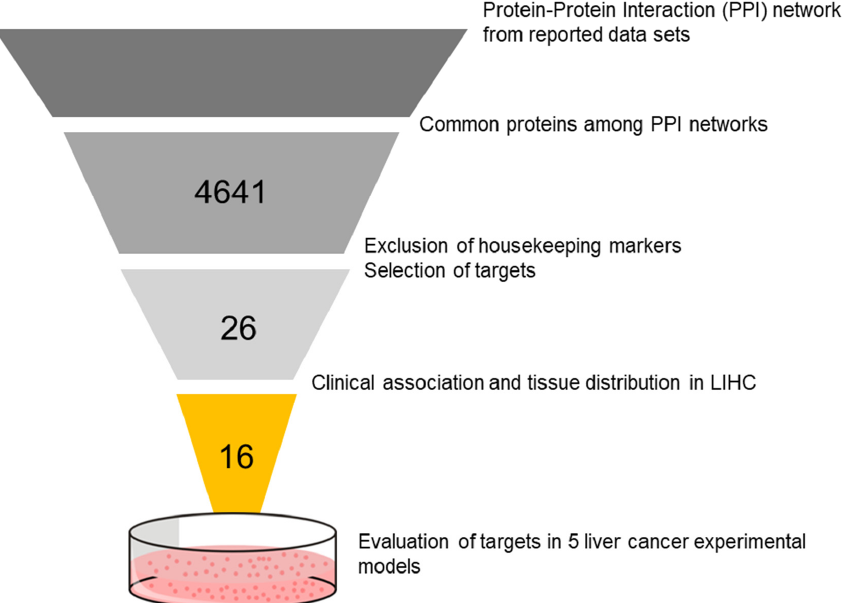
Figure 1. Simplified graphical illustration of the in silico and validation approach to discover potential targets for HCC therapy.